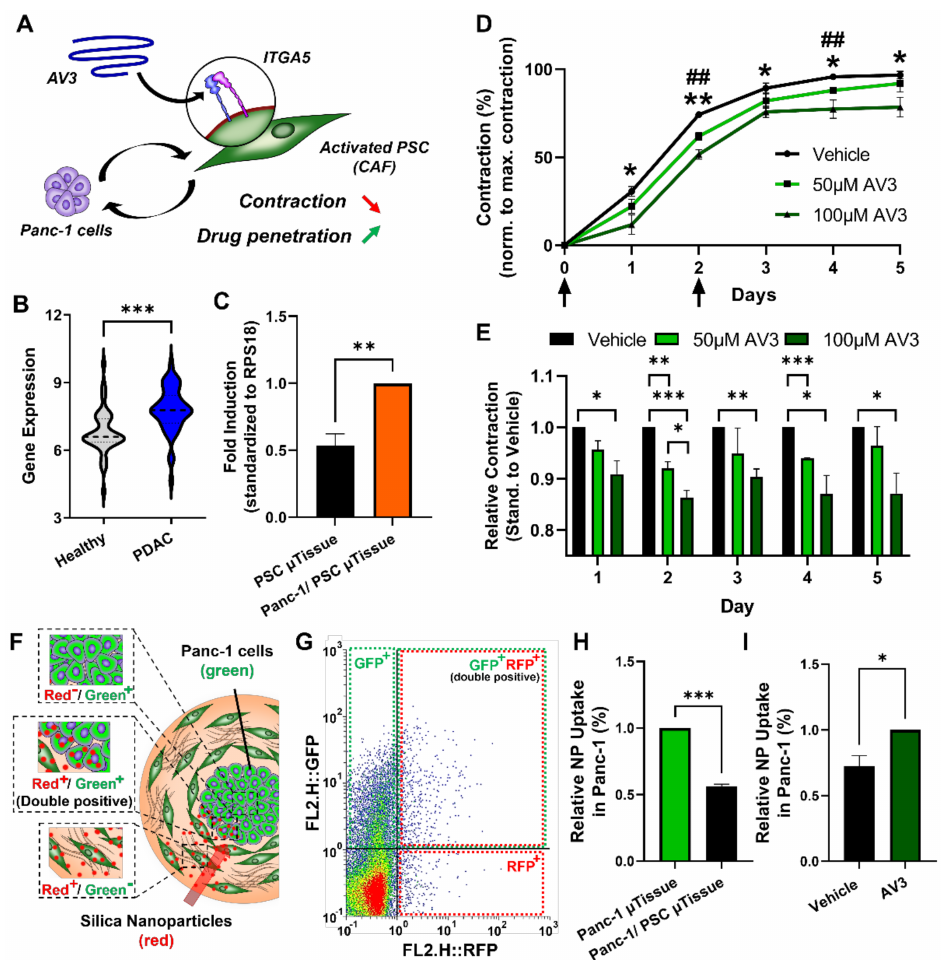
Figure 7. Treatment of Panc-1/PSC µ tissues with ITGA5 antagonist AV3. ( A ) Schematic repre- sentation of the mechanism of action of AV3. ( B ) Expression of ITGA5 in human PDAC patients. ( C ) Expression of ITGA5 in Panc-1/PSC µ tissues compared to PSC µ tissues alone. ( D ) Size of Panc-1/PSC µ tissues treated with 50 µ M and 100 µ M AV3 for a culture duration of 5 days. Arrows in- dicating days of treatment. * indicates significance comparing treatment with vehicle versus 100 µ M AV3. # indicates significance comparing treatment with vehicle versus 50 µ M AV3. ( E ) Relative contraction of Panc-1/PSC µ tissues treated with 50 µ M and 100 µ M AV3 for each day of culture. ( F ) Schematic representation of the experimental setup demonstrating the penetration of red fluores- cent silica nanoparticles into Panc-1/PSC µ tissues containing green fluorescent-labelled Panc-1 cancer cells, highlighting cells only positive for nanoparticles (red + /green − ), positive for both, nanoparticles and green-labeling (double positive red + /green + ) and cells only positive for the green-labeling (red − /green + ). ( G ) Dot plot of flow cytometry analysis highlighting the different subpopulations in the Panc-1/PSC µ tissues. ( H ) Relative number of double-positive cells in Panc-1 µ tissues versus Panc-1/PSC µ tissues. ( I ) Relative number of double-positive cells in Panc-1/PSC µ tissues treated vehicle (DMSO) or 50 µ M AV3 (same Panc-1/PSC µ tissues were used for data presented in ( H , I )). Data represent mean ± standard error of the mean for at least 3 independent experiments. Statistical analysis was performed by two-tailed Student’s t -test. * p < 0.05, ** , ## p < 0.01, *** p <